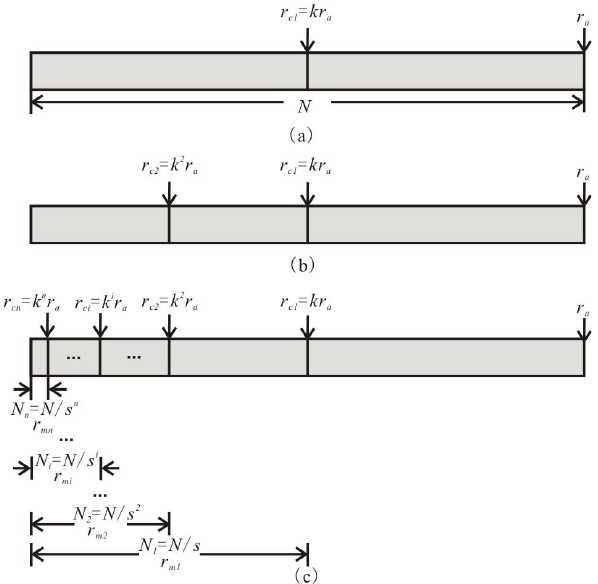
Fig. 1. Model for establishing the generalized number-size